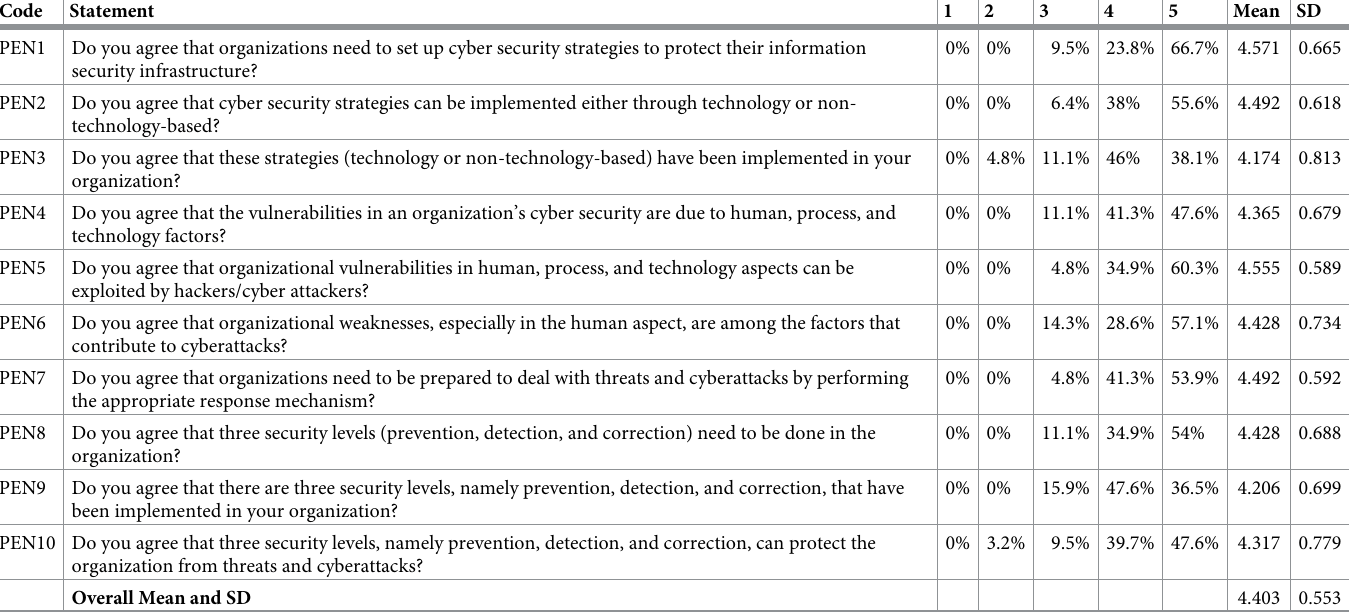
Table 15. Questionnaire results on the evaluation of organizational cyber security